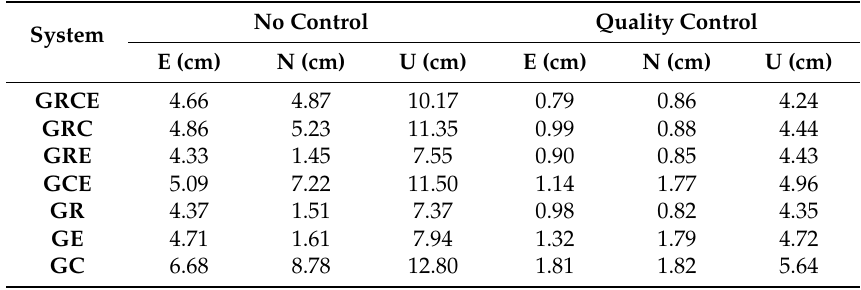
Table 2. The RMS statistic of the positioning error in east, north, and upward components after convergence.